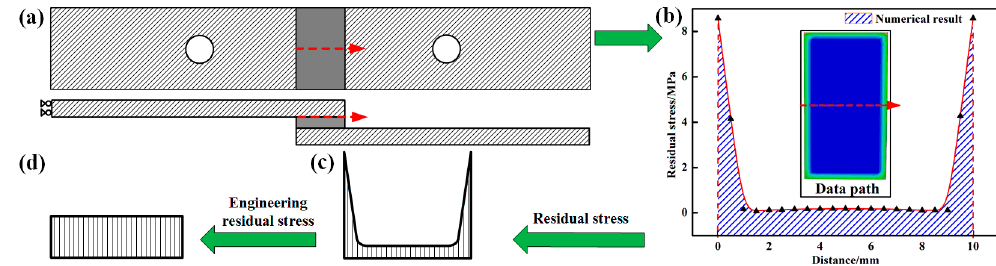
Figure 10. Schematic diagram of the residual stress transformation process to engineering residual stress. ( a ) specimen diagrammatic drawing; ( b ) residual stress distribution in test path; ( c ) residual stress; ( d ) engineering residual stress.